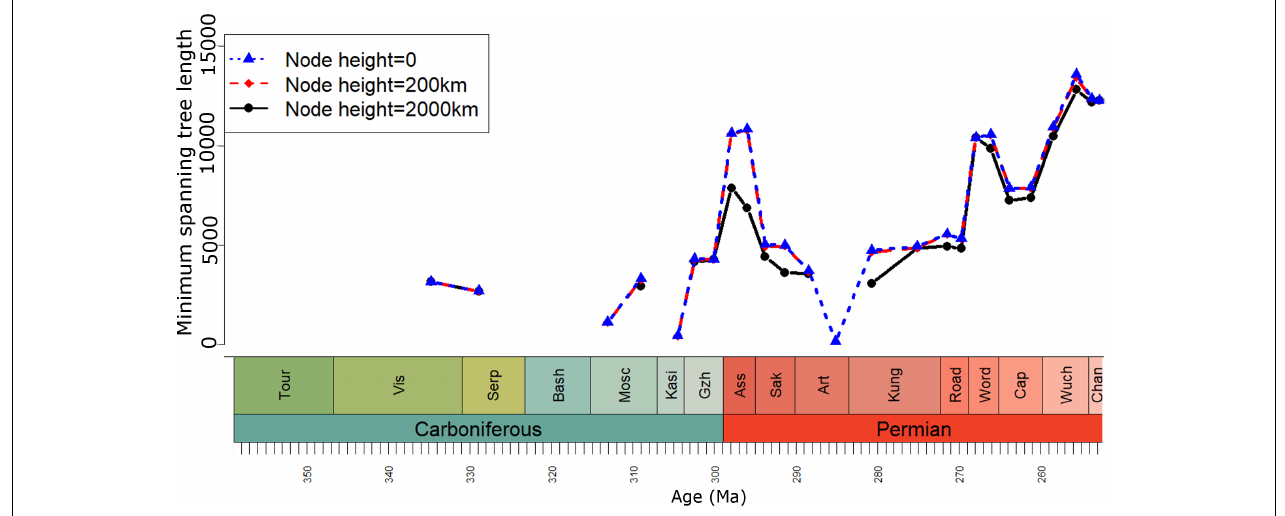
FIGURE 3 | Geographic spread of sampling of tetrapods in each time bin, measured as the minimum spanning tree length between bioregions defined at three geographic cluster node heights. TABLE 2 | Details of the time bins used to define the parameters of Geographic Spread Subsampling. Geographic cluster Time bin with lowest Lower geographic distance bound node height (km) geographic spread of between bioregion pairs included in sampling beta diversity estimate